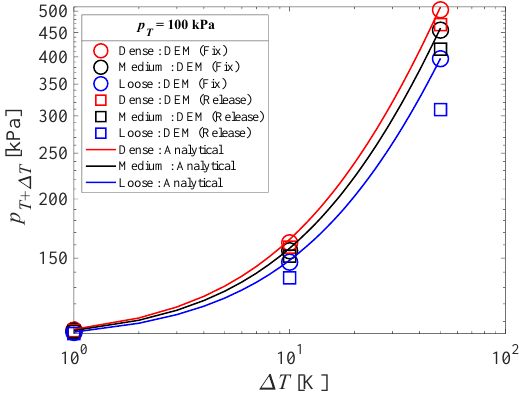
Fig. 1 . Comparison between Analytical and DEM 𝑝 𝑇+Δ𝑇 values ( 𝑝 𝑇 = 100 kPa).